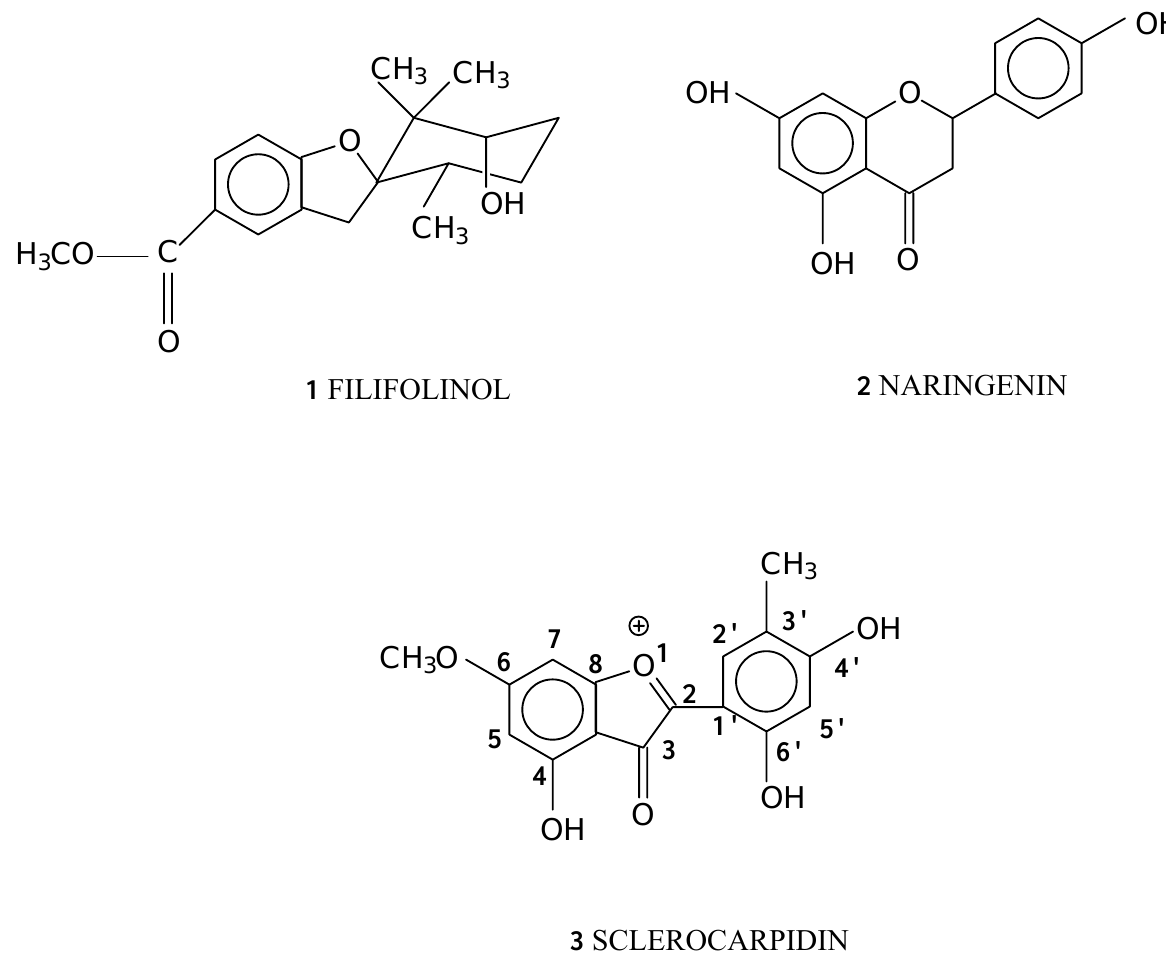
Figure 1. Compounds isolated from resinous exudates obtained of Heliotropium sclerocarpum